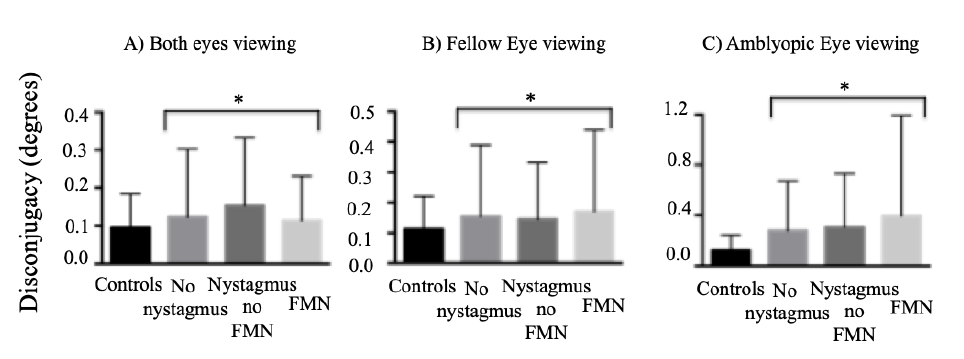
Fig.6: Mean and standard deviation of disconjugacy of composite amplitude of fixational saccades in controls and patients without nystagmus, and quick phases in patients with nystagmus across eye movement waveforms during both eyes viewing (A), fellow eye viewing (B) and amblyopic eye viewing (C) conditions. Amblyopic patients have in- creased disconjugacy under all viewing